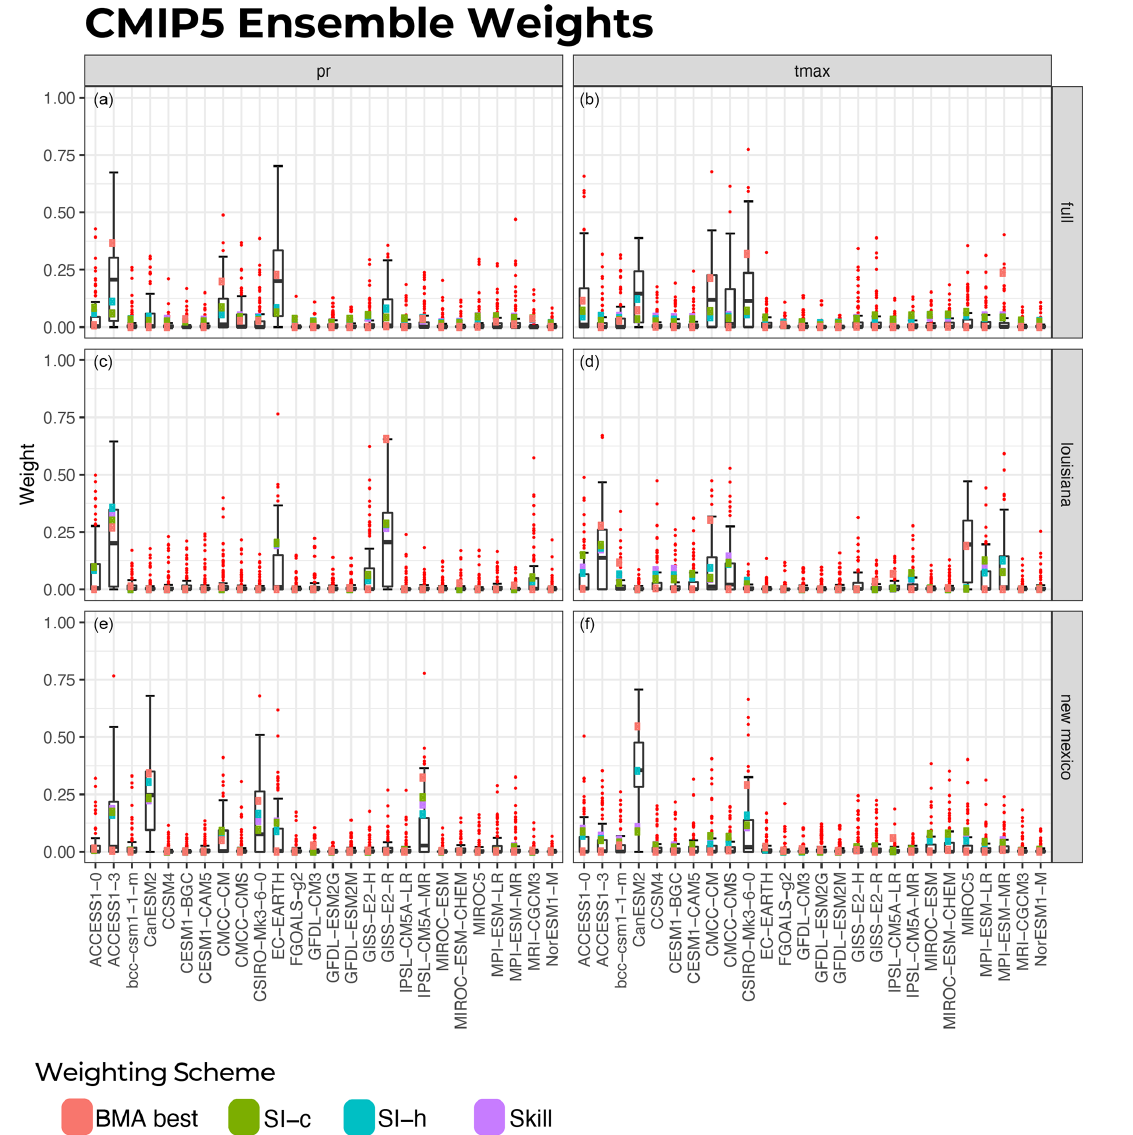
Figure 3. Model weights for each of the four weighting schemes using the CMIP5 ensemble. Panels (a, c, e) show weights based on precipitation (pr) alone, and panels (b, d, f) show weights based on high temperature (tmax) alone. Panels (a, b) show weights based on the full domain, (c, d) weights based on Louisiana alone, and (e, f) weights based on New Mexico alone. The box plots are the spread of weights from the 100 iterations of the BMA weighting scheme. The red dots depict the outliers from the BMA distributions of